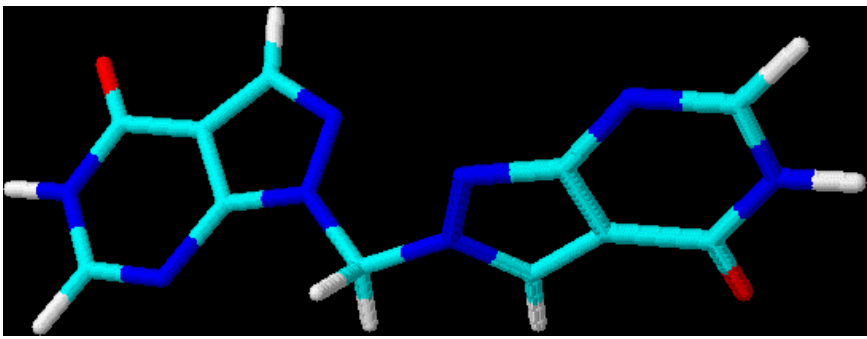
Figure 3 . 3D-Optimized structure of compound 4b